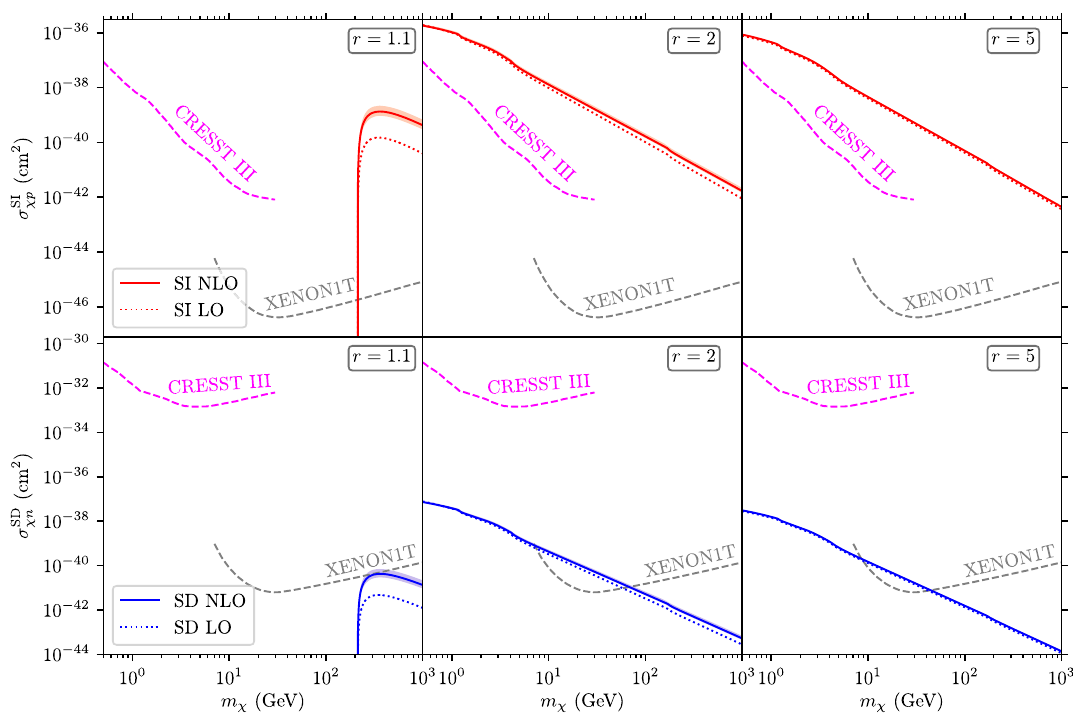
Fig. 4 SI DM-proton (top) and SD DM-neutron (bottom) scattering cross sections for the t -channel model of Eq. (2) for given values of r = M med / m χ at LO (dotted) and NLO (solid), with bands indicating their renormalization scale dependence. Additionally, current exclu-